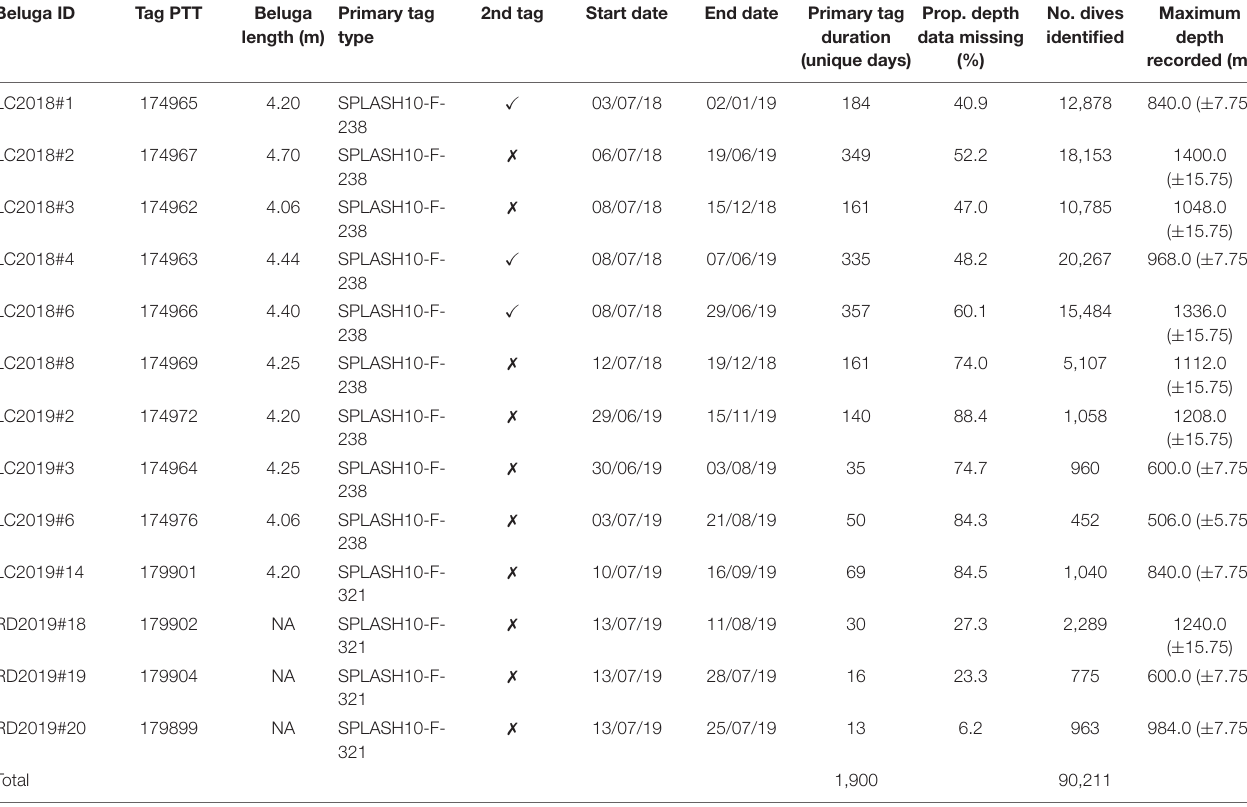
TABLE 1 | Tag deployments, data retrieved, and number of dives identified using